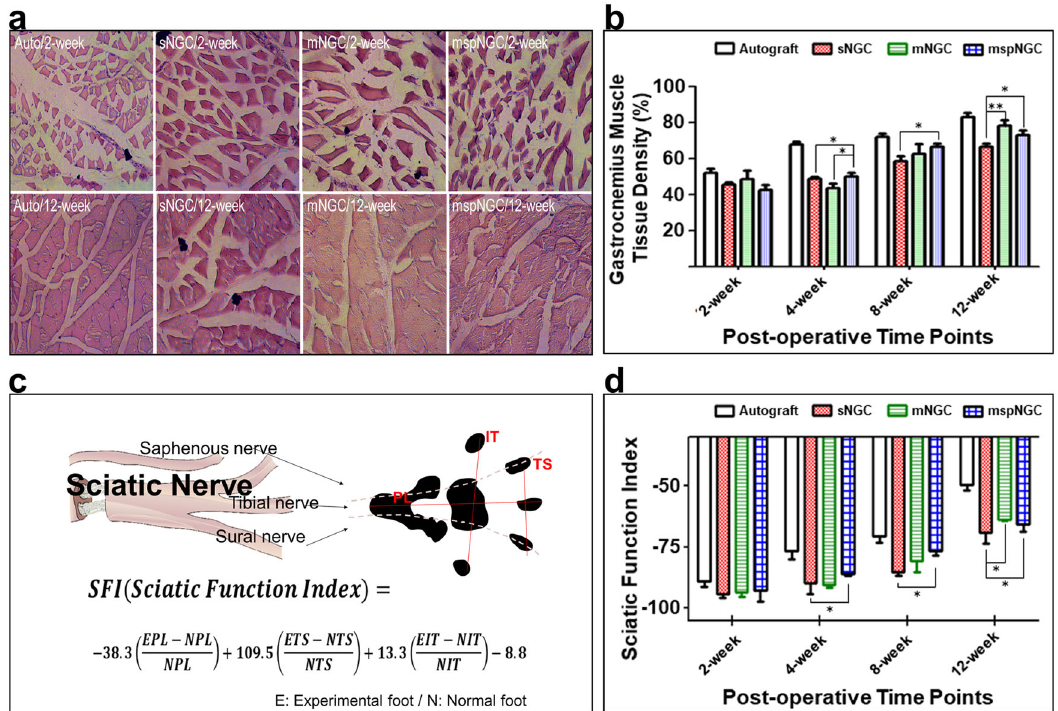
Fig. 5 Evaluation of the functional recovery mediated by NGCs. a Optical images of H&E stained gastrocnemius muscle tissue of each group at various time points. b Gastrocnemius muscle tissue densities of each group at the indicated post-operative time points ( n = 6 samples, * p < 0.05; ** p < 0.01). c Schematic depiction of the SFI analysis. d SFI values of each implant group at post-operative time points ( n = 4 samples, * p < 0.05). Values are p resented as mean ± SD.